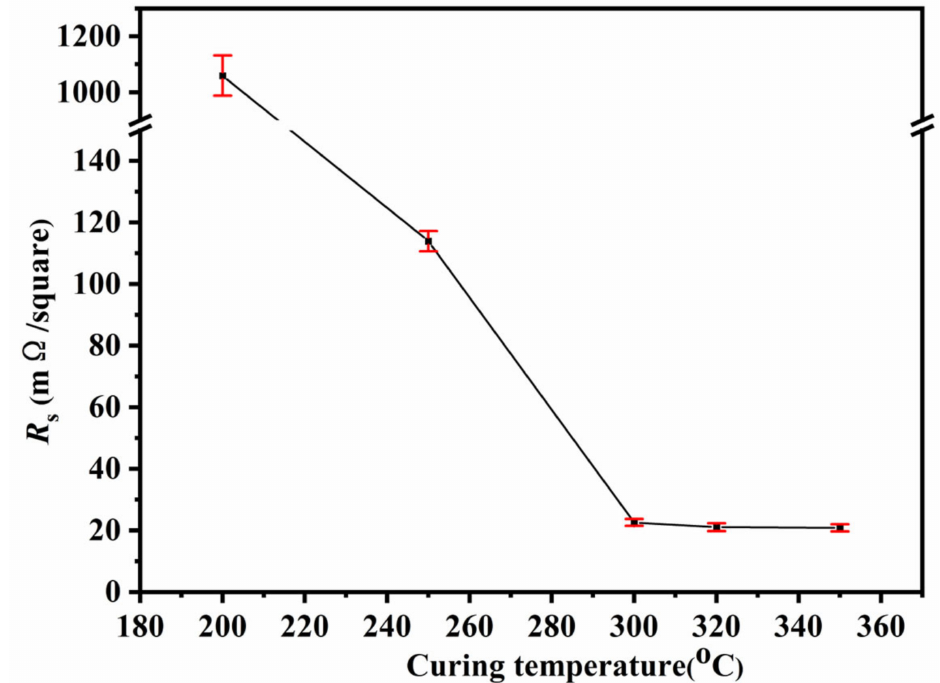
Figure 4. The R s of cured silver pastes with different curing